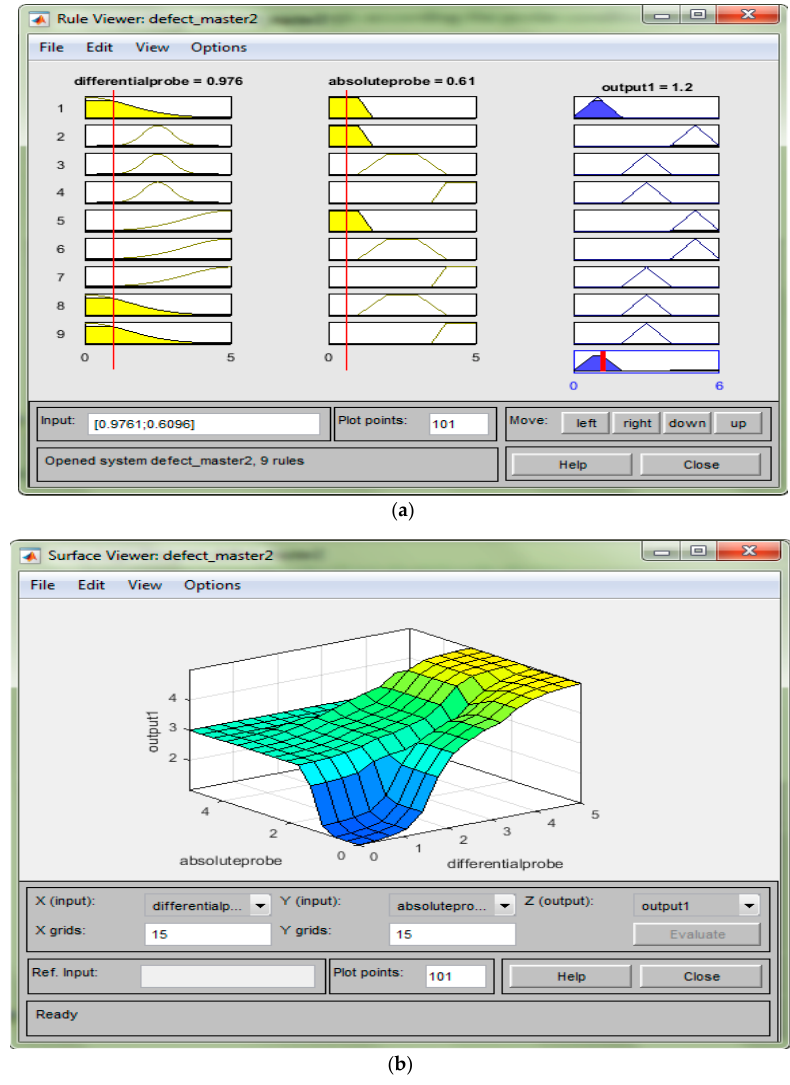
Figure 6. ( a ) Rule viewer; ( b ) Surface viewer.